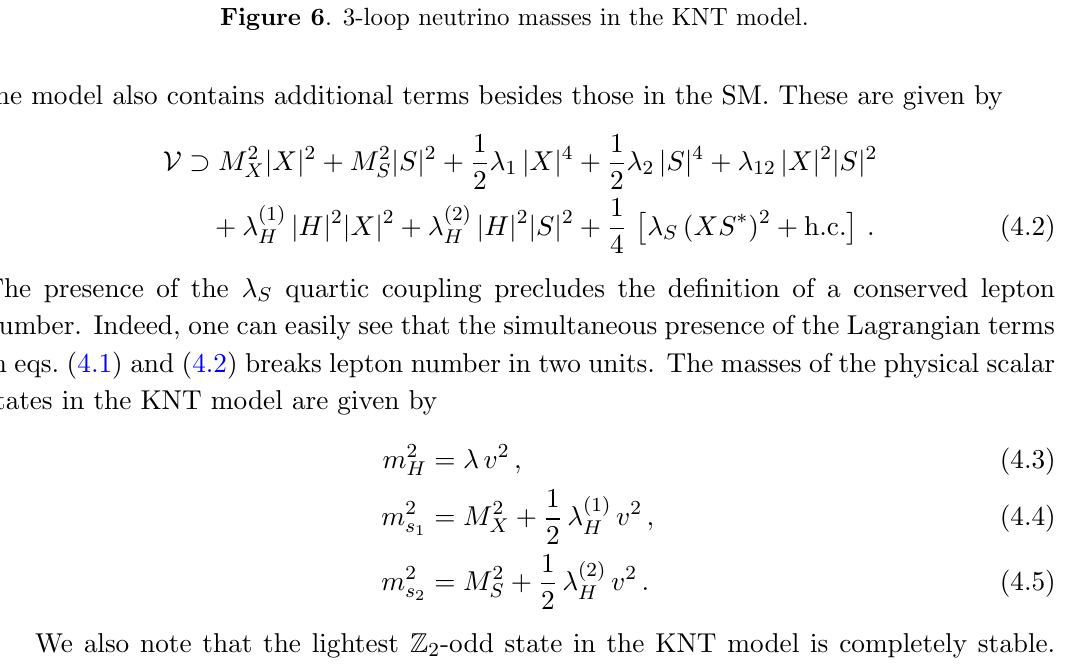
Figure 6 . 3-loop neutrino masses in the KNT